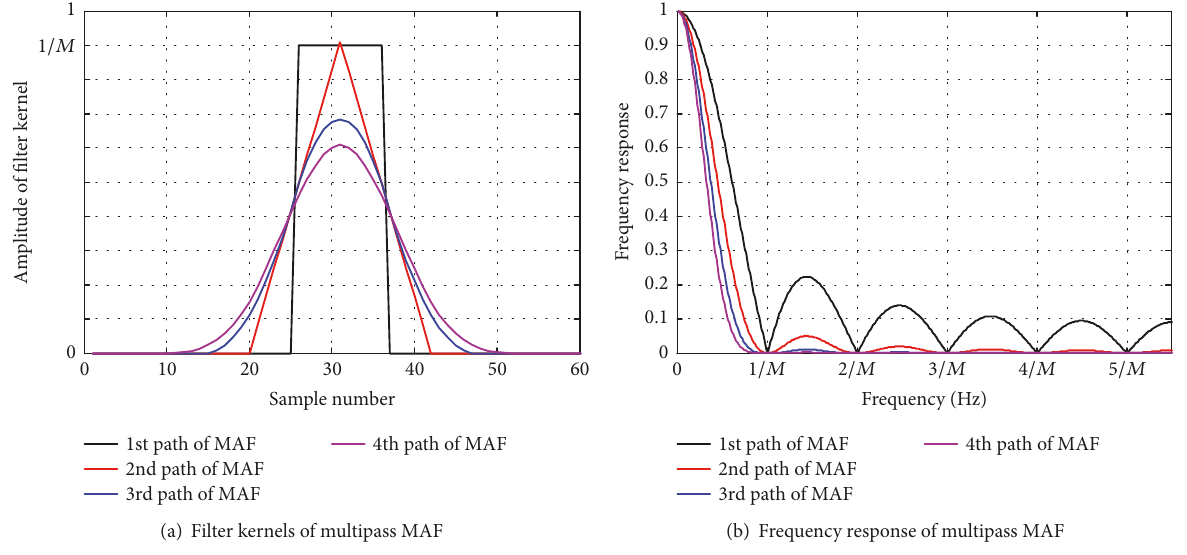
Figure 2: Filter kernels of MAF when applied more than once and its frequency response using